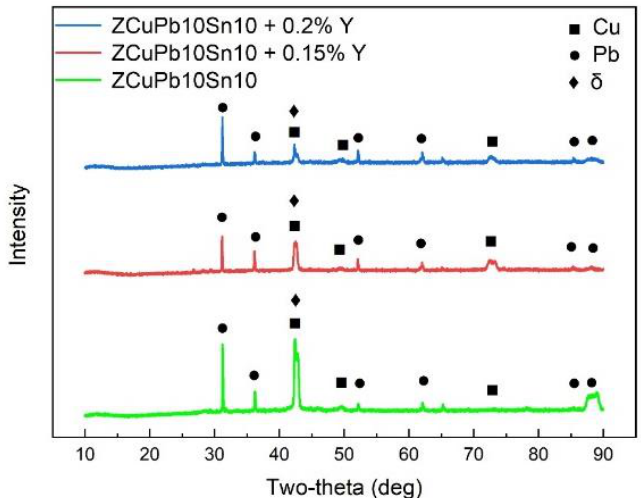
Figure 8. XRD results of the alloys with different Y contents.